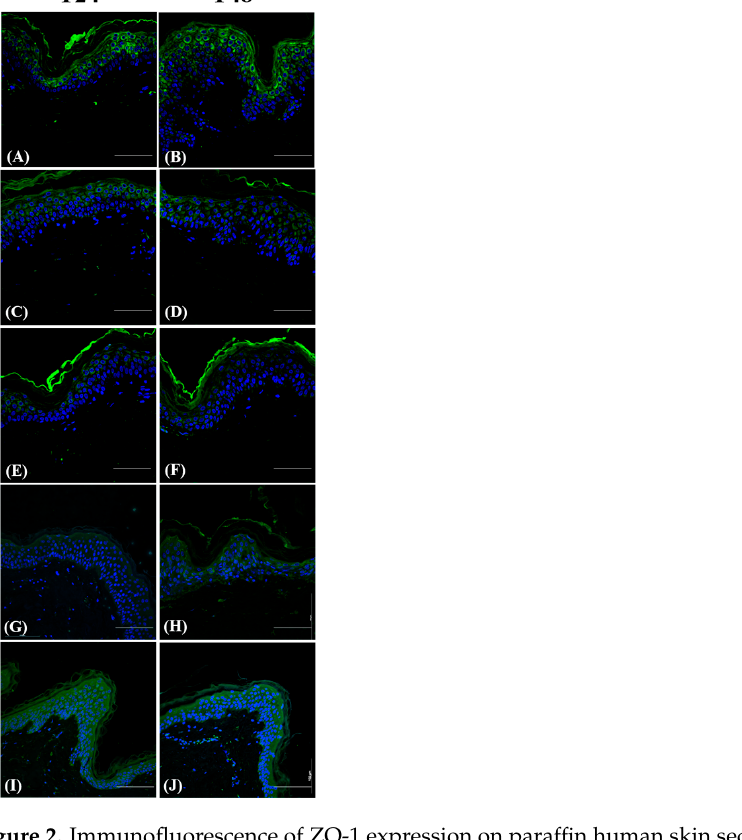
Figure 2. Immunofluorescence of ZO-1 expression on paraffin human skin sections. Representative ZO-1 immunostaining in normal human skin paraffin sections. ( A , C , E , G , I ): samples harvested at 24 h; ( B , D , F , H , J ): samples harvested at 48 h. ( A , B ): CTR samples; (C, D): IL-4-treated samples; ( E , F ): IL-13-treated samples; ( G , H ): IL-22-treated samples; ( I , J ): IL-23-treated samples. Nuclei are counterstained with DAPI. ZO-1: zonula occludens 1. CTR: control; IL-4: interleukin 4; IL-13: interleukin 13; IL-22: interleukin 22; IL-23: interleukin 23; DAPI: 4 ′ , 6-diamidino-2-phenylindoledihydrochloride—scale bars: 50 μ m.